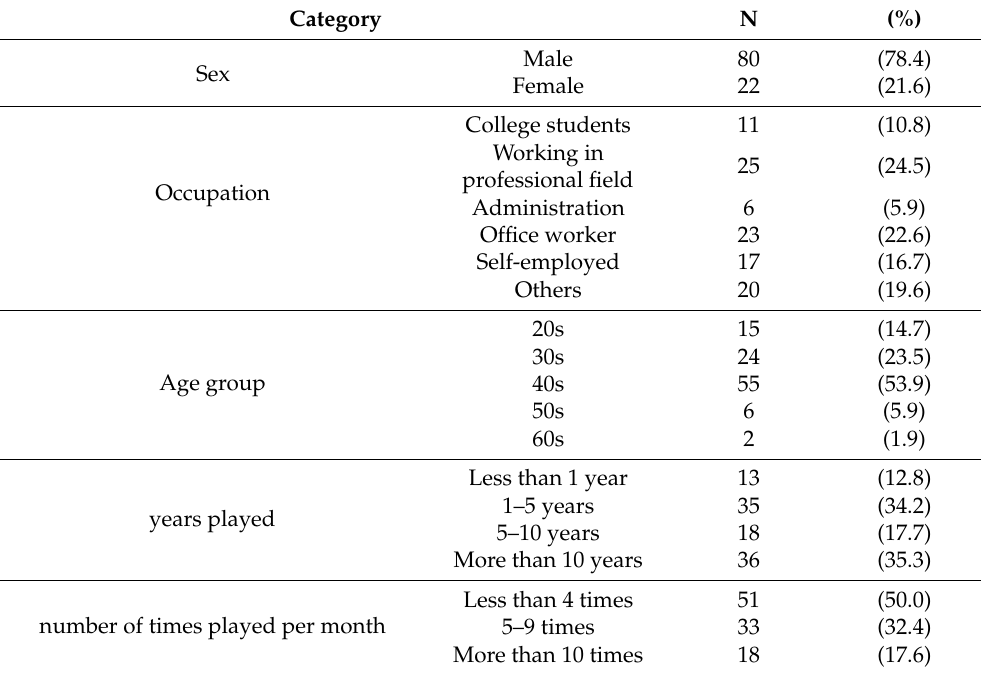
Table 2. Characteristics of Survey